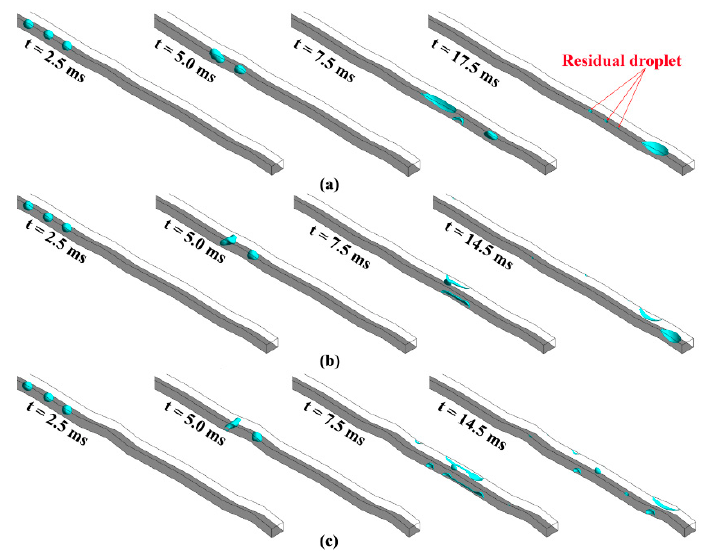
Figure 11. Temporal droplet flow in different configurations for multiple droplets (r = 200 μ m): ( a ) Design 1; ( b ) Design 2; ( c ) Design 3 channels at an inlet velocity of 12.5 ms − 1 and contact angles of θ GDL = 120°, θ side; top = 82°; 45°, respectively.